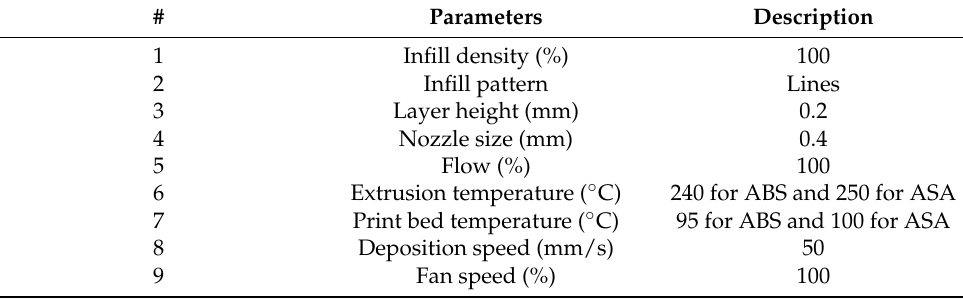
Table 1. Process parameters for ABS and